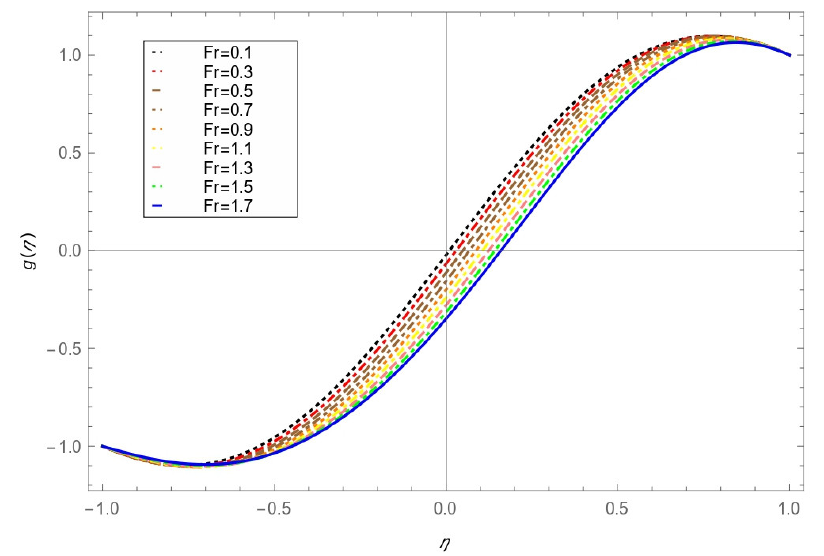
Figure 6. Tangential velocity profile effect of the Forchheimer number for α = 2, Re = 1, ϕ 1 = ϕ 2 = 0.01, dp 1 = dp 2 = 10, M = 2, β =